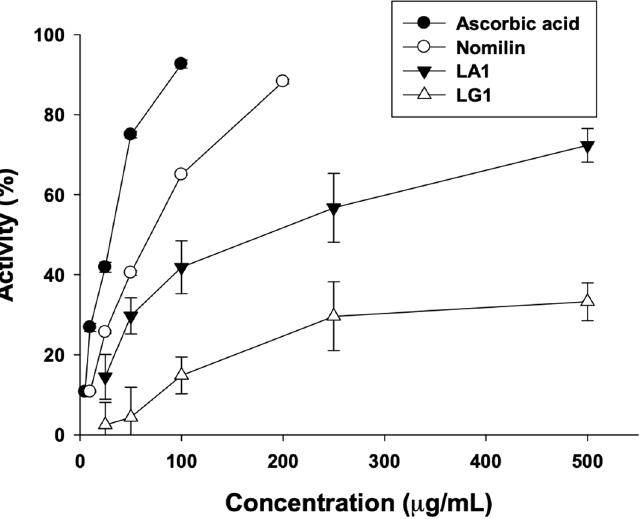
Figure 3. The inhibitory effect of ascorbic acid, nomilin, LA1, and LG1 on mushroom tyrosinase in a cell-free system. LA: limonoid aglycone, LG: limonoid glucoside.